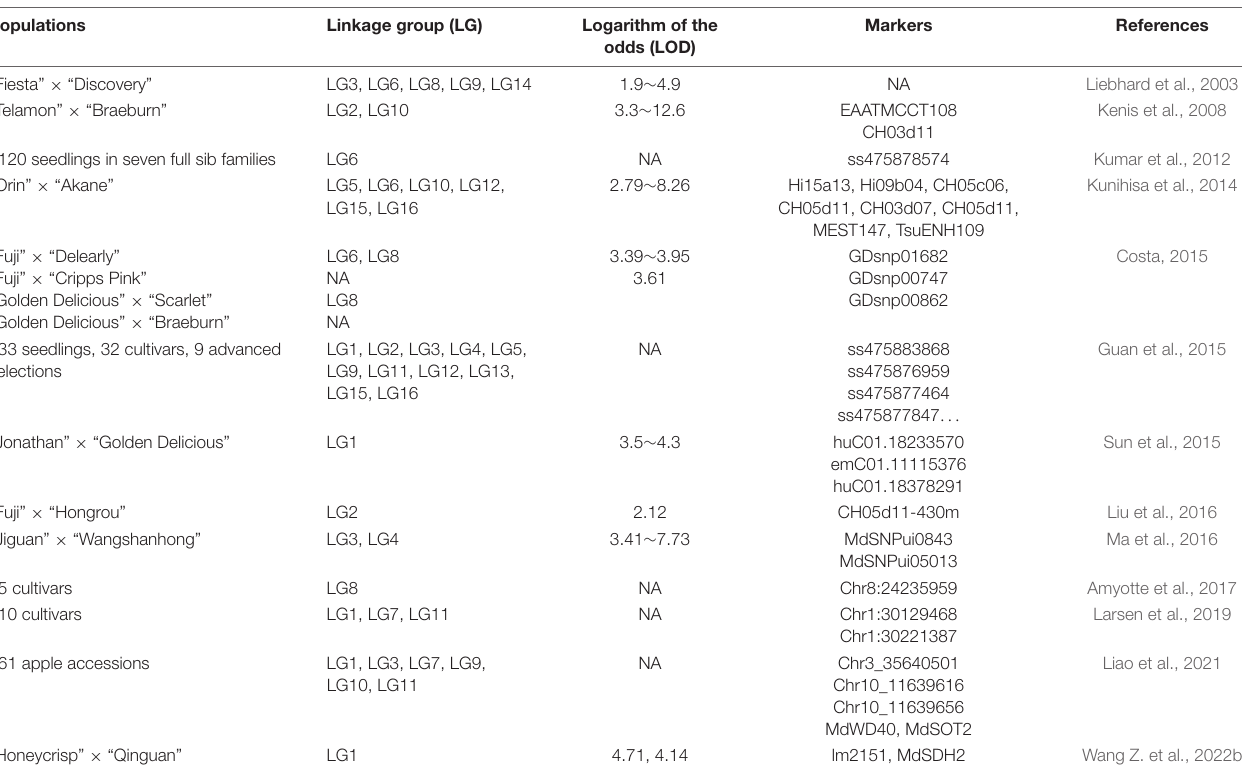
TABLE 1 | Linkage mapping for soluble sugar content in apple